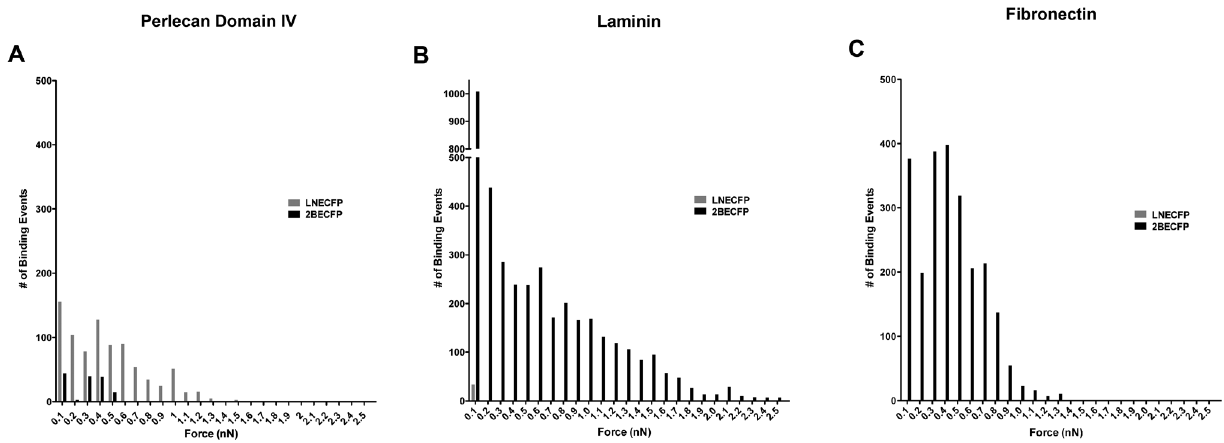
Figure 7. Binding force distribution of perlecan domain IV (A), laminin (B), and fibronectin (C) attached to an AFM tip engaged to either LNECFP or 2BECFP cells plated on a 60 mm tissue culture dish. A . Binding between a perlecan domain IV-coated AFM tip and an LNECFP cell displays a more broad binding force distribution than their 2BECFP counterparts. B . 2BECFP LNCaP cells display a very wide force distribution relative to LNECFP cells with a laminin-treated AFM tip. C . When the tip is coated with fibronectin, LNECFP cells display a narrow force distribution compared to 2BECFP cells (n=3).